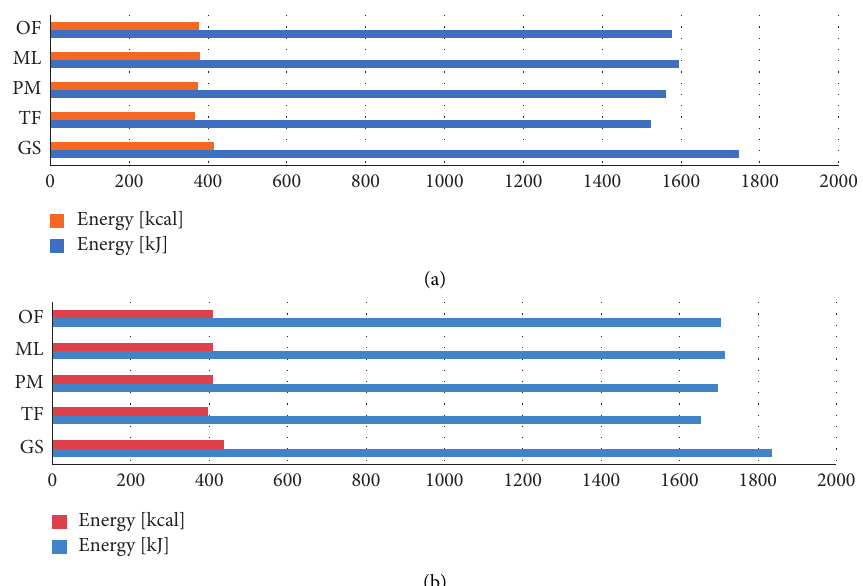
Figure 3: (a) Energy value of high-protein bars without chocolate covering; (b) with chocolate covering. OF oligofructose, TF—tapioca liquid fiber, ML—maltitol, PM—chickpea-maize liquid